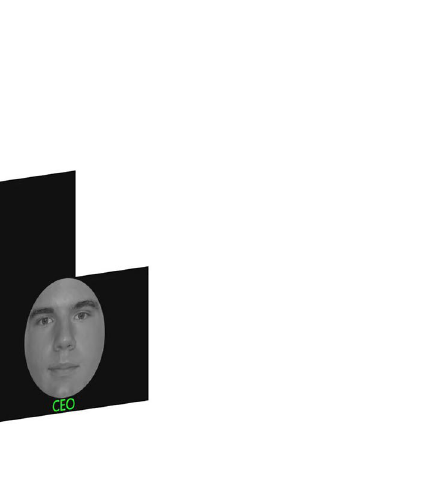
Figure 2. Flow chart of the experiment in Study